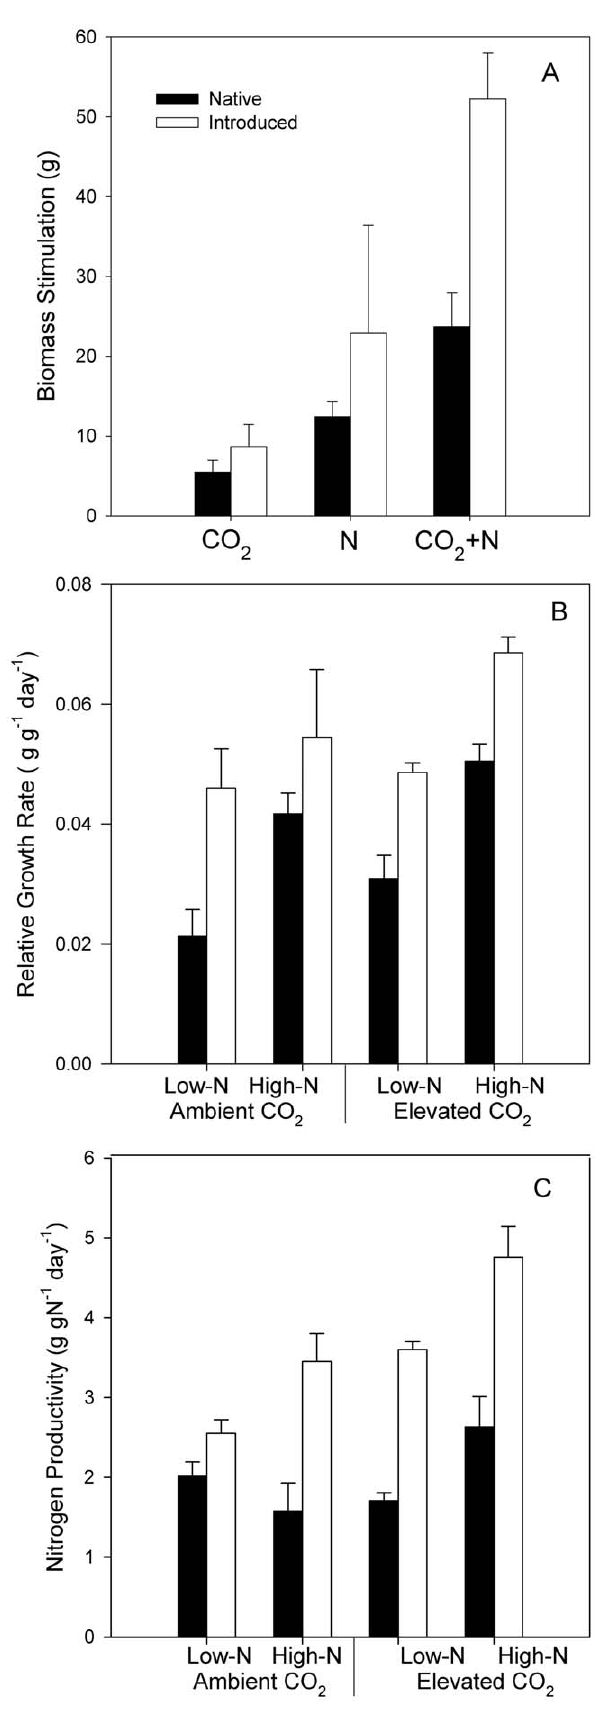
Figure 1. Effects of CO 2 and N treatments on Phragmites biomass stimulation ± standard error (A), relative growth rate (RGR) ± standard error (B), and plant nitrogen productivity (NP) ± standard error (C). Solid bars indicate native Phragmites and empty bars indicated introduced Phragmites